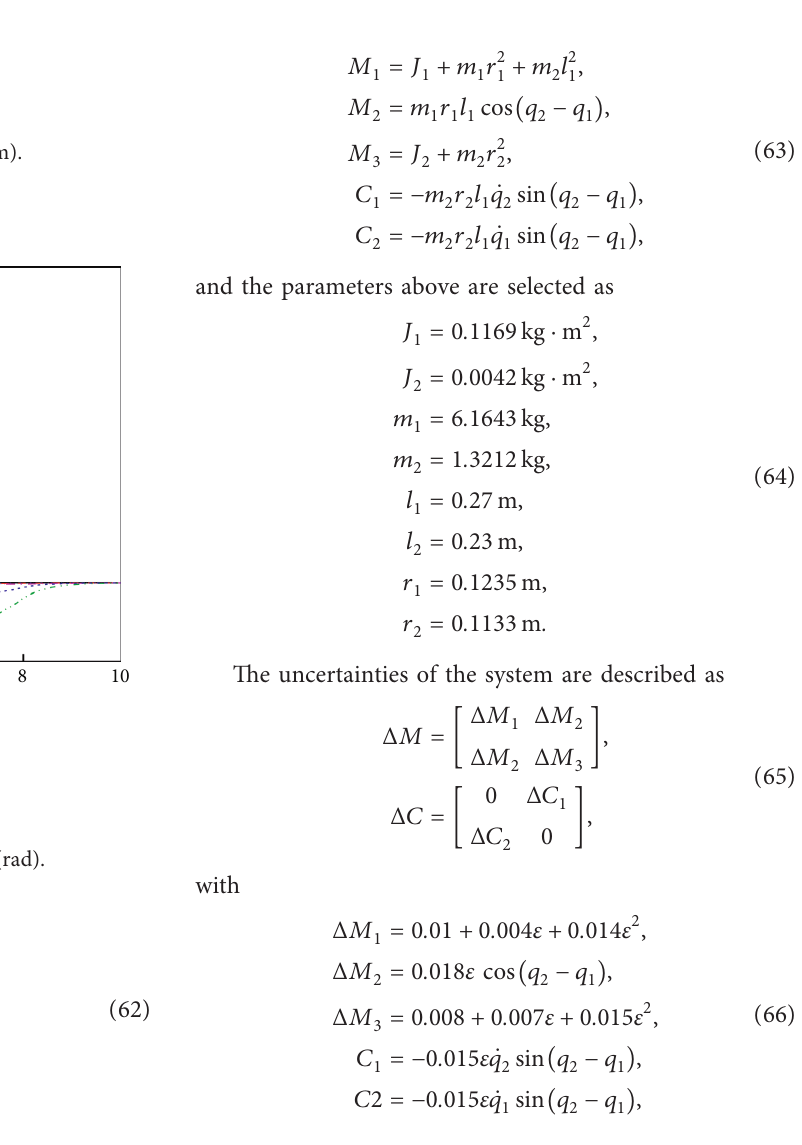
Figure 10: Mechanical model of the double-joint robotic